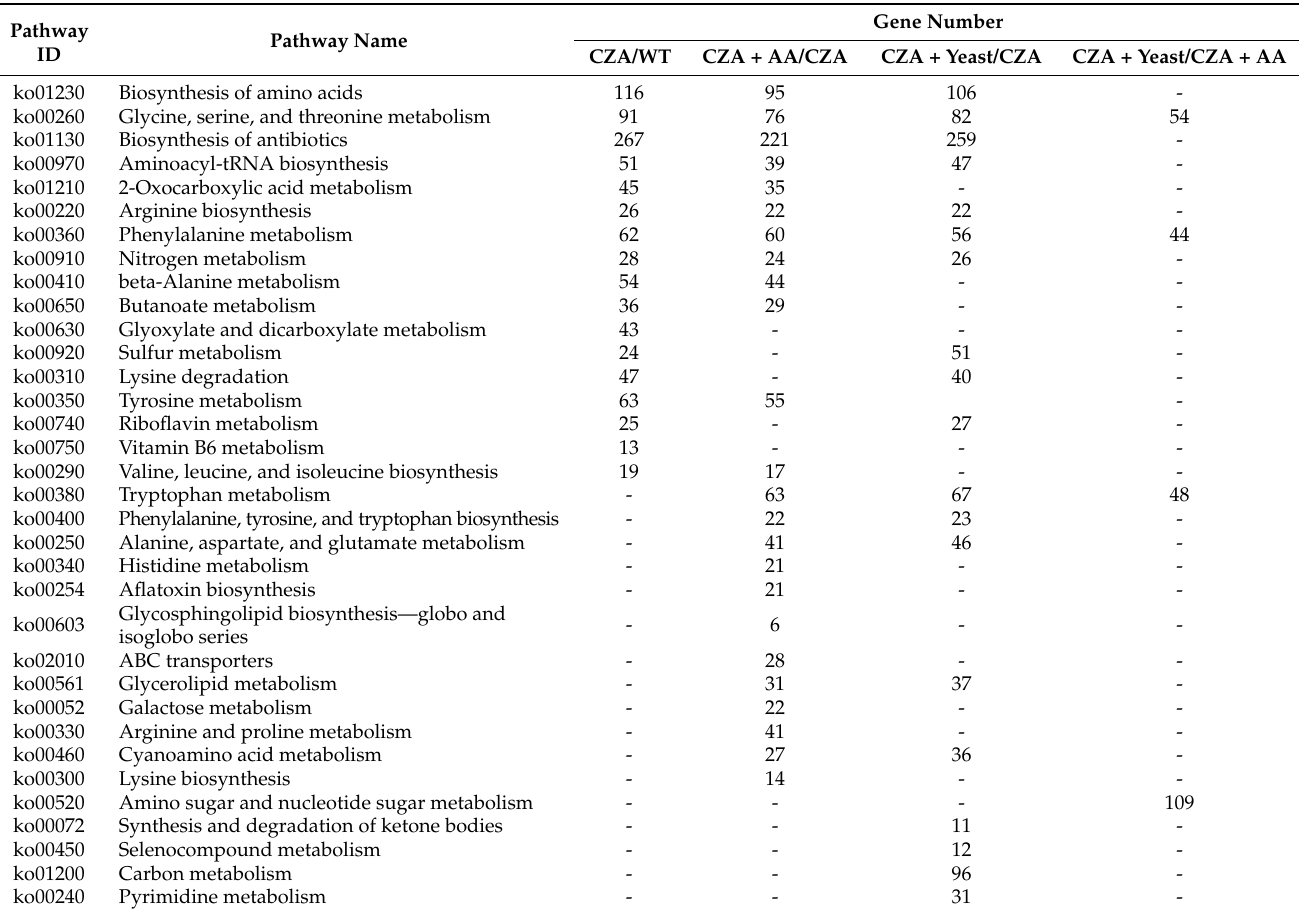
Table 1. KEGG analysis of differentially expressed